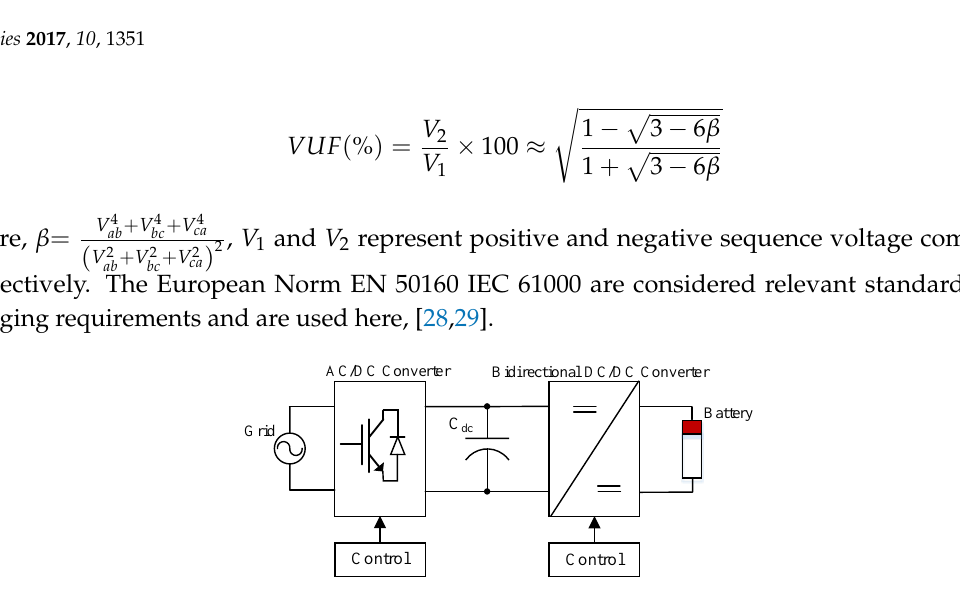
Figure 5. EV integration scheme.